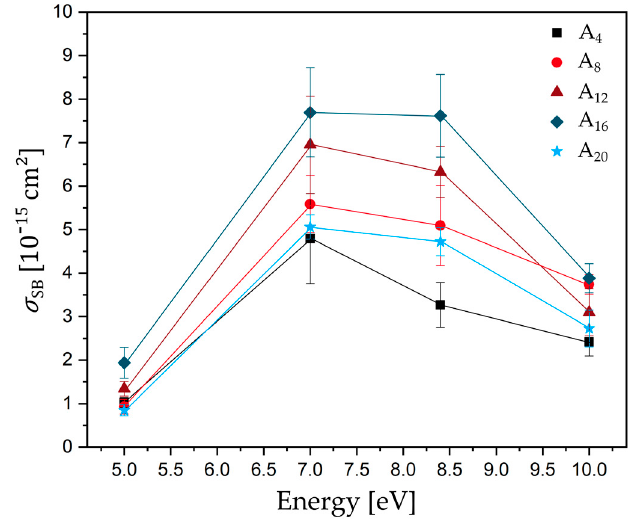
Figure 3. Plot of absolute DNA strand break cross section for di ff erent single stranded DNA sequences (d(A 4 ) black-square, d(A 8 ) light red-circle, d(A 12 ) dark red-triangle, d(A 16 ) dark blue-diamond, and d(A 20 ) light blue-star) as a function of the electron energy. Solid lines connect the data points to guide the eye.